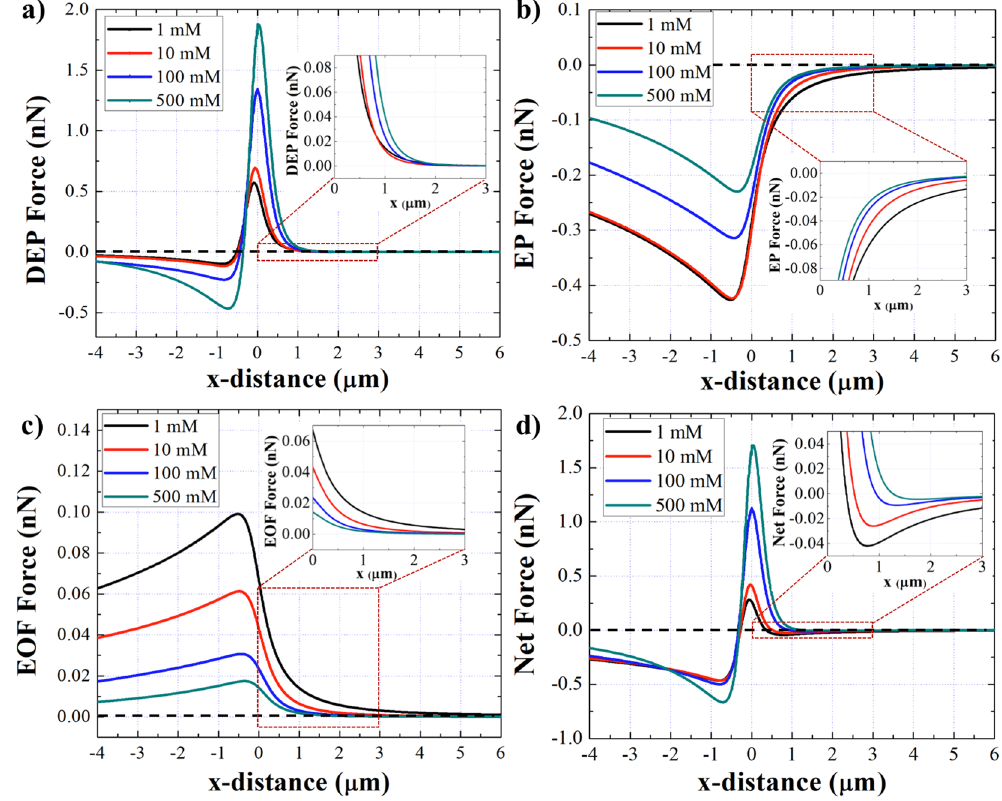
Figure 3. ( a – d ) The plot of DEP, EP, EOF and the net force applied on the 510 nm COOH-PS beads along the length of the 1 μ m pipette under different ionic strengths. A positive 10 V/cm bias was applied at the base of the pipette. The zoom in figures show the distribution of EK forces within a close distance from the pipette’s tip at the trapping